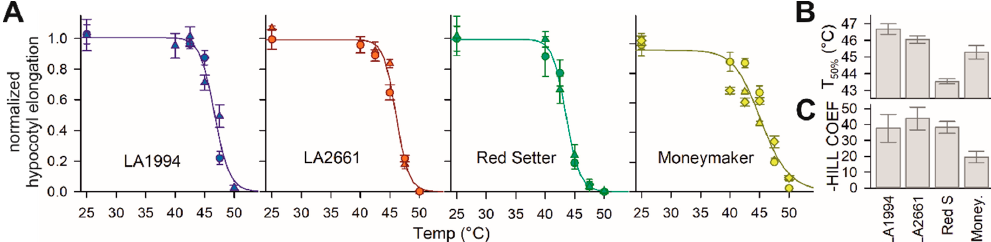
Figure 1. Temperature sensitivity of different genotypes. ( A ) The values for hypocotyl growth (cm day − 1 ) were normalized to the growth of untreated seedlings and are presented as symbols for different biological replicas. The line represents the least square fit analysis of the data to Equation (1). Error bars are standard deviations for the di ff erent plants for one replica ( n > 8). ( B ) The values of T 50% (EC50) for the four genotypes are shown. The standard error of the fit is shown as an error bar. ( C ) The values of the negative Hill-slope are shown. The standard error of the fit is shown as an error